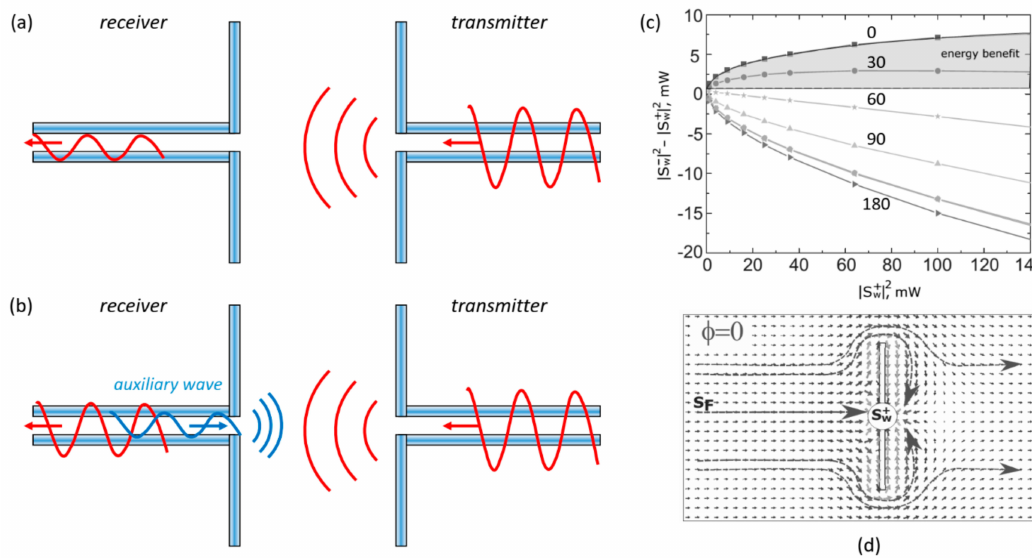
Figure 3. ( a ) Traditional wireless power transfer (WPT) system consisting of transmitter antenna (right) and receiver antenna (left). ( b ) Coherently enhanced wireless power transfer system with the receiver antenna driven coherently by an auxiliary wave (shown in blue). ( c ) Net extracted energy as a function of the auxiliary signal intensity for di ff erent relative phase values (from 0 to 180 grad). Filled area indicates the region of energy benefit, where the coherently assisted energy balance exceeds that for s + w = 0. ( d ) Poynting vector distribution around the antenna with the auxiliary signal s + w and relative phase of 0 deg. ( c , d ) Reprinted with permission from